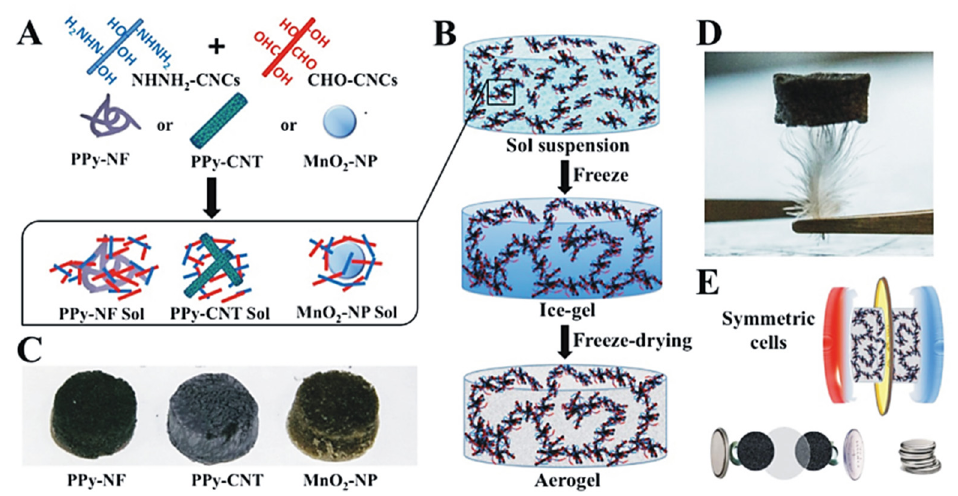
Figure 18. ( A ) The schematic presentation of the aerogel components including functionalized CNCs and capacitive nanoparticles, which form the initial suspension of cross-linked clusters. ( B ) The sol–gel process used to prepare aerogels. ( C ) Photograph of the final hybrid aerogels with a diameter of 1.5 cm. ( D ) Photograph emphasizing the lightweight nature of a hybrid aerogel resting on the top of a feather. ( E ) Schematic presentation showing the fabrication of symmetric supercapacitor cells in the CR2032-type coin-cell cases with two hybrid aerogels separated by a porous polyethylene membrane in a saturated Na 2 SO 4 aqueous electrolyte [352]. Copyright 2015 John Wiley & Sons Inc. Reproduced with permission.